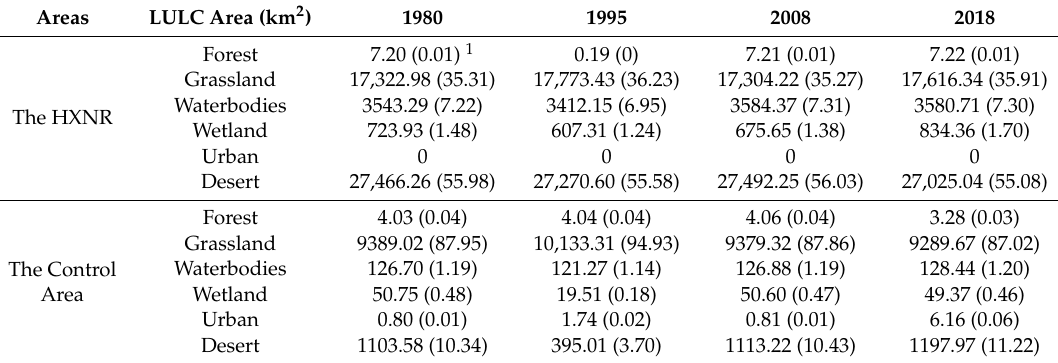
Table 2. The area of di ff erent land use / land cover types in the study area during 1980–2018.